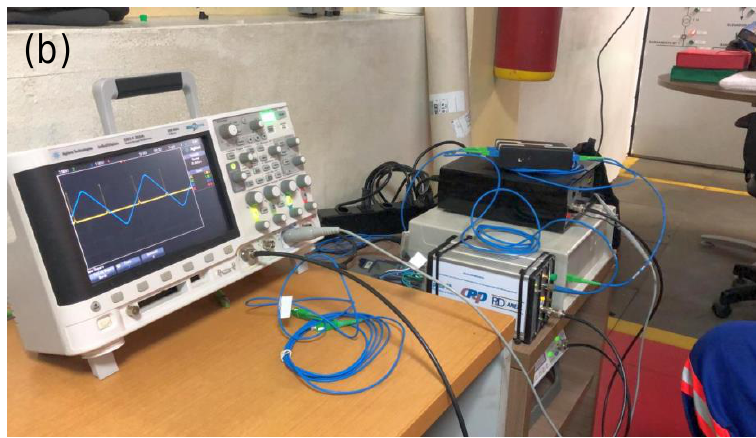
Figure 9. ( a ) Point in the engine where the FBG pressure sensor was installed and ( b ) interrogator and the demodulator tool kit installed in a control room 50 m from the engine under test.